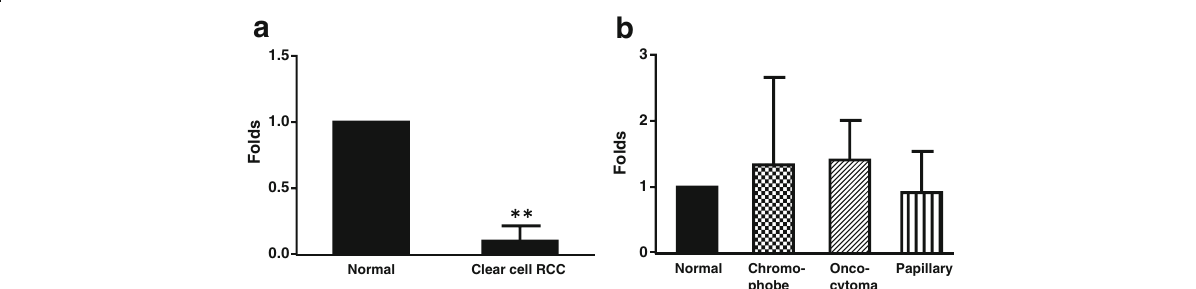
Fig. 3 TGR5 mRNA expression. A. TGR5 mRNA was significantly decreased in clear cell RCC ( N = 5, un-paired t test), when compared with normal renal tissue. The data suggest that decreased TGR5 protein expression may be due to downregulation of TGR5 mRNA in clear cell RCC. B. TGR5 mRNA expression in papillary RCCs, chromophobe RCCs and oncocytomas reveal no significant differences from normal renal tissue ( N =3 – 5,